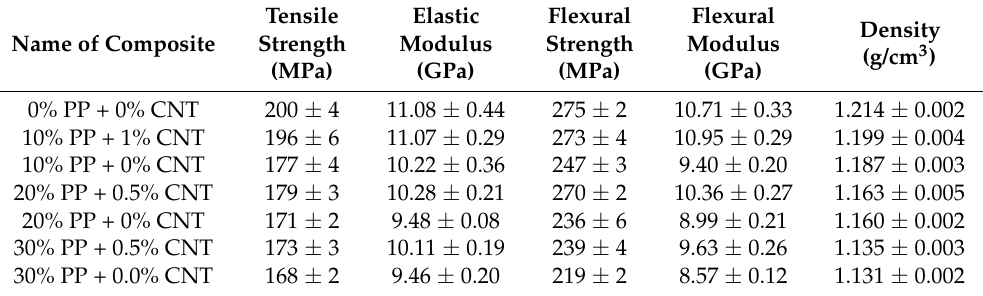
Figure 10. FE-SEM images of the interfaces between CF and the matrix of 30% PP composite on the fractured surface ( a ) without CNTs and ( b ) with 1 wt % CNTs. Table 4. Comparison of mechanical properties and densities of CF-reinforced PA6/PP composites without CNTs and with CNTs.